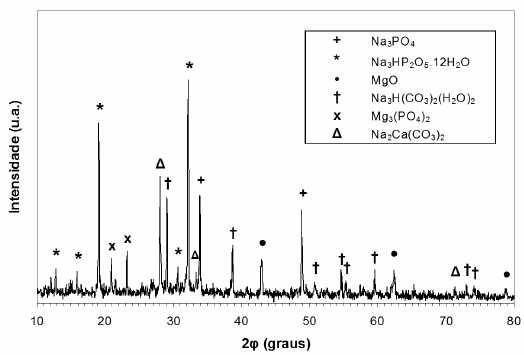
Figure 9. XRD pattern of efflorescence powder, obtained from the surface of magnesium phosphate cement mortars containing powder grinding. Table 5. Comparison of the solubilization tests of magnesium phosphate cement mortars, as a function of grinding dust contents after 28 days and 1 year of age.